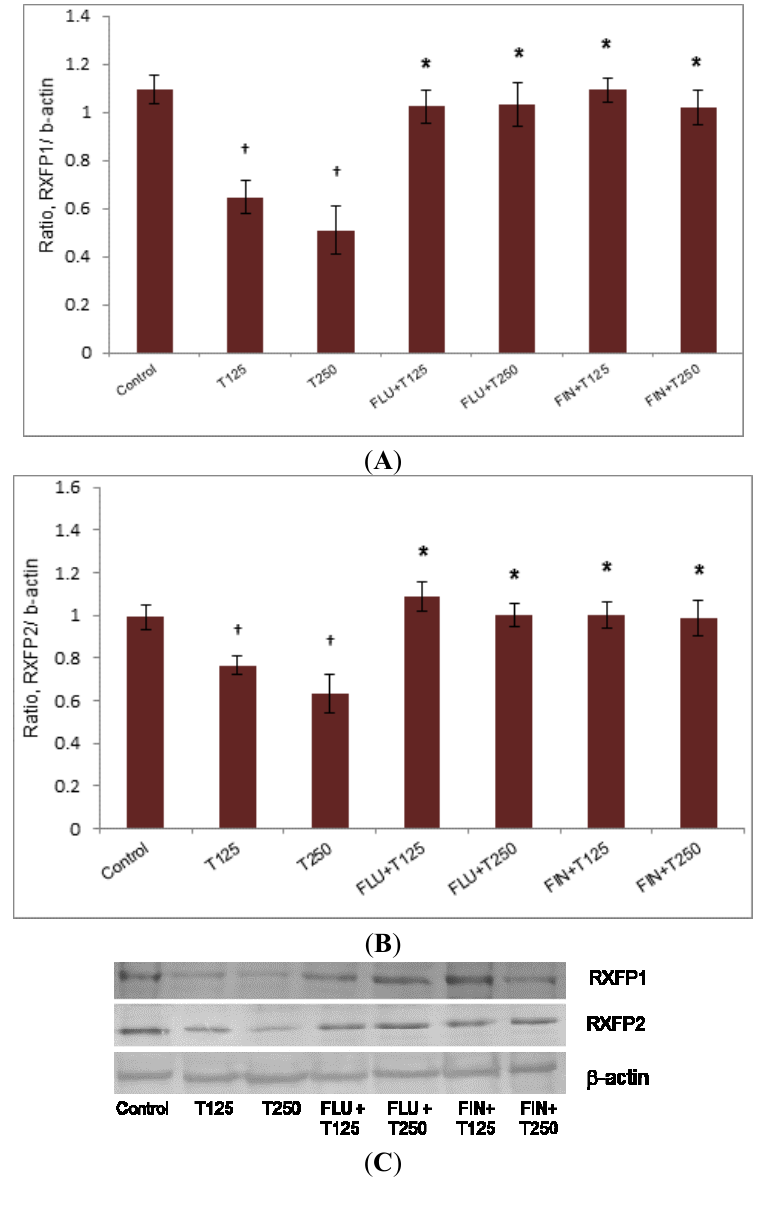
effect of FIN indicated that DHT and not testosterone mediates the inhibition of Rxfp1 and Rxfp2 protein expression ( C ) (Data were expressed as mean ± SEM, n = 6 per treatment group; T125: 125 μ g testosterone; T250: 250 μ g testosterone; FLU: 10 mg/kg flutamide; FIN: 20 mg/kg finasteride). † p < 0.05 as compared to control; * p < 0.05 as compared to testosterone only treatment for the respective